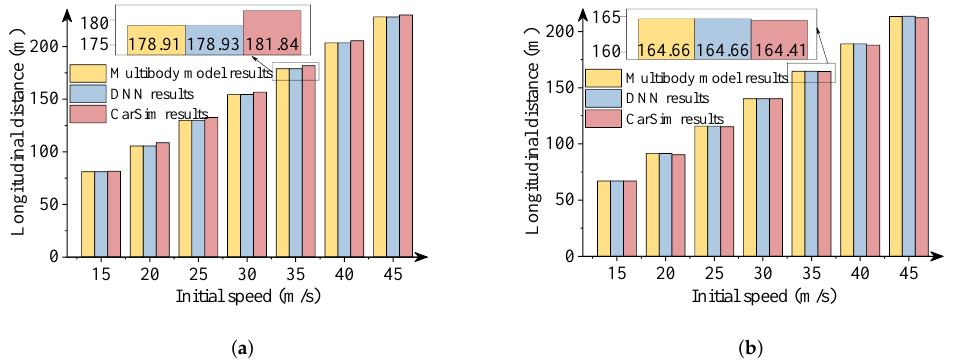
Figure 11. Comparison of longitudinal distances. ( a ) 300 Nm driving torque; ( b ) − 300 Nm driv- ing torque.